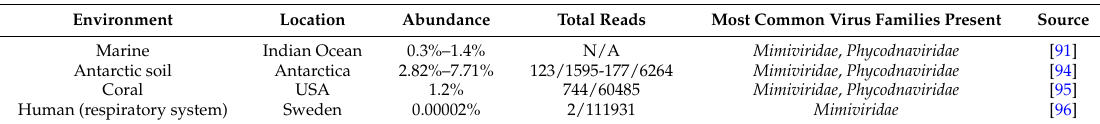
Table 2. Comparison of giant virus reads to total viral reads in shotgun metagenomic studies from different